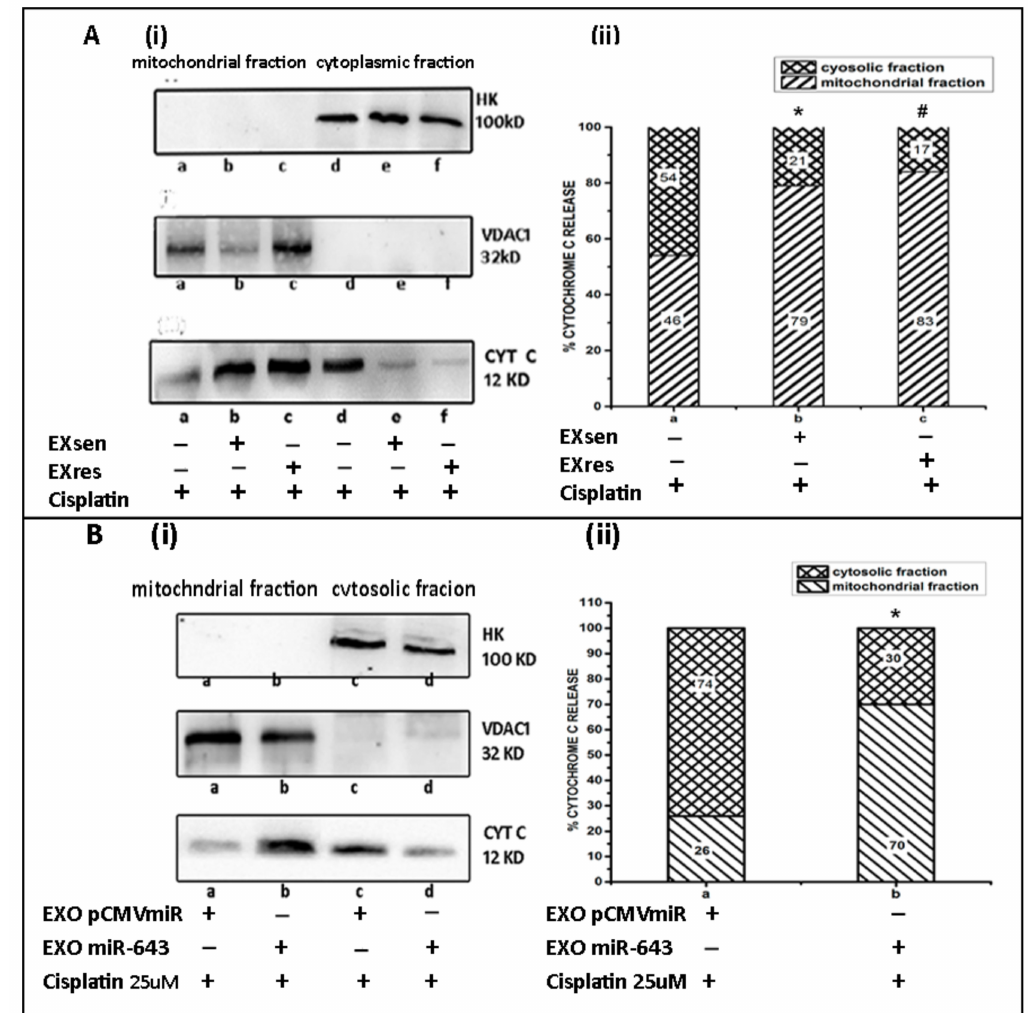
Figure 11. miR-643-mediated modulation of cisplatin resistance in Hela cells is dependent on APOL6-induced release of cytochrome C. ( A ) ( i ) Levels of HK, VDAC1, and CYT C proteins analysed by Western blot from mitochondrial and cytplasmic fractions of Hela cells treated with EXsen/EXresand cisplatin. In ( A ) ( i ), a—mitochondrial fractions of cells exposed to cisplatin, b—mitochondrial fractions of cells exposed to EXsen + cisplatin and c—mitochondrial fractions of cells exposed to EXres +cisplatin, d—cytosolic fraction of cells exposed to cisplatin, e—cytosolic fraction of cells exposed to EXsen + cisplatin and f—cytosolic fraction of cells exposed to EXres + cisplatin. ( ii ). The relative proportion of cytosolic to mitochondrial cytochrome c from EXsen/EXres and cisplatin-treated Hela cells was calculated and presented in graphical form. In ( A ) ( ii ) a—cells exposed to cisplatin, b—cells exposed to EXsen + cisplatin and c—cells exposed to EXres + cisplatin. ( B ) ( i ) Levels of HK, VDAC1, and CYT C proteins analysed by Western blot from mitochondrial and cytplasmic fractions of Hela cells treated with EXO miR-643 . In ( B ) ( i ) a—mitochondrial fraction of Hela cells exposed to EXO pCMVmiR and cisplatin, b—mitochondrial fraction of Hela cells exposed to EXO miR-643 and cisplatin, c—cytosolic fraction of Hela cells exposed to EXO pCMVmiR and cisplatin, d—cytosolic fraction of Hela cells exposed to EXO miR-643 and cisplatin. ( ii ) The relative proportion of cytosolic to mitochondrial cytochrome c from Hela cells treated with EXO miR-643 was calculated and presented in graphical form. In ( C ) ( ii ) a—Hela cells exposed to EXO pCMVmiR and cisplatin, b—Hela cells exposed to EXO miR-643 and cisplatin. The mean values of two different experiments ± SEM each performed in triplicate are reported in the graph, p < 0.05. * indicates statistical significance when compared to a. # indicates statistical significance when compared to